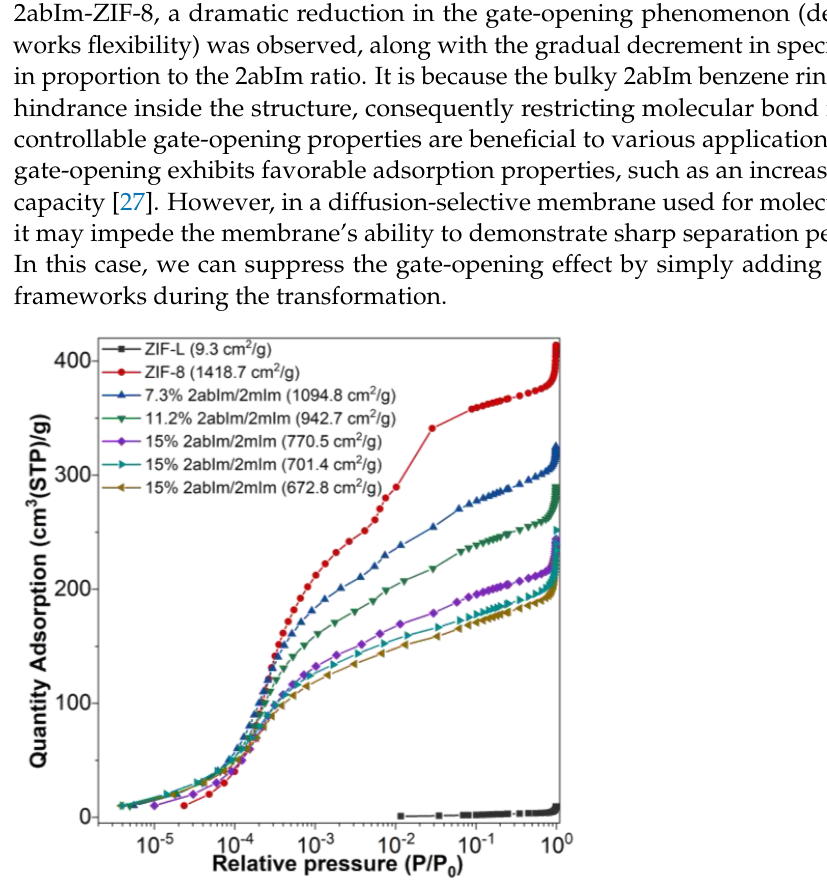
Figure 5. N 2 adsorption isotherms of ZIF-L, ZIF-L-derived ZIF-8, and 2abIm-ZIF-8 varying 2abIm/2mIm ratios. Table 1. Summary of pH as a function of the DMAc/H2O ratio.